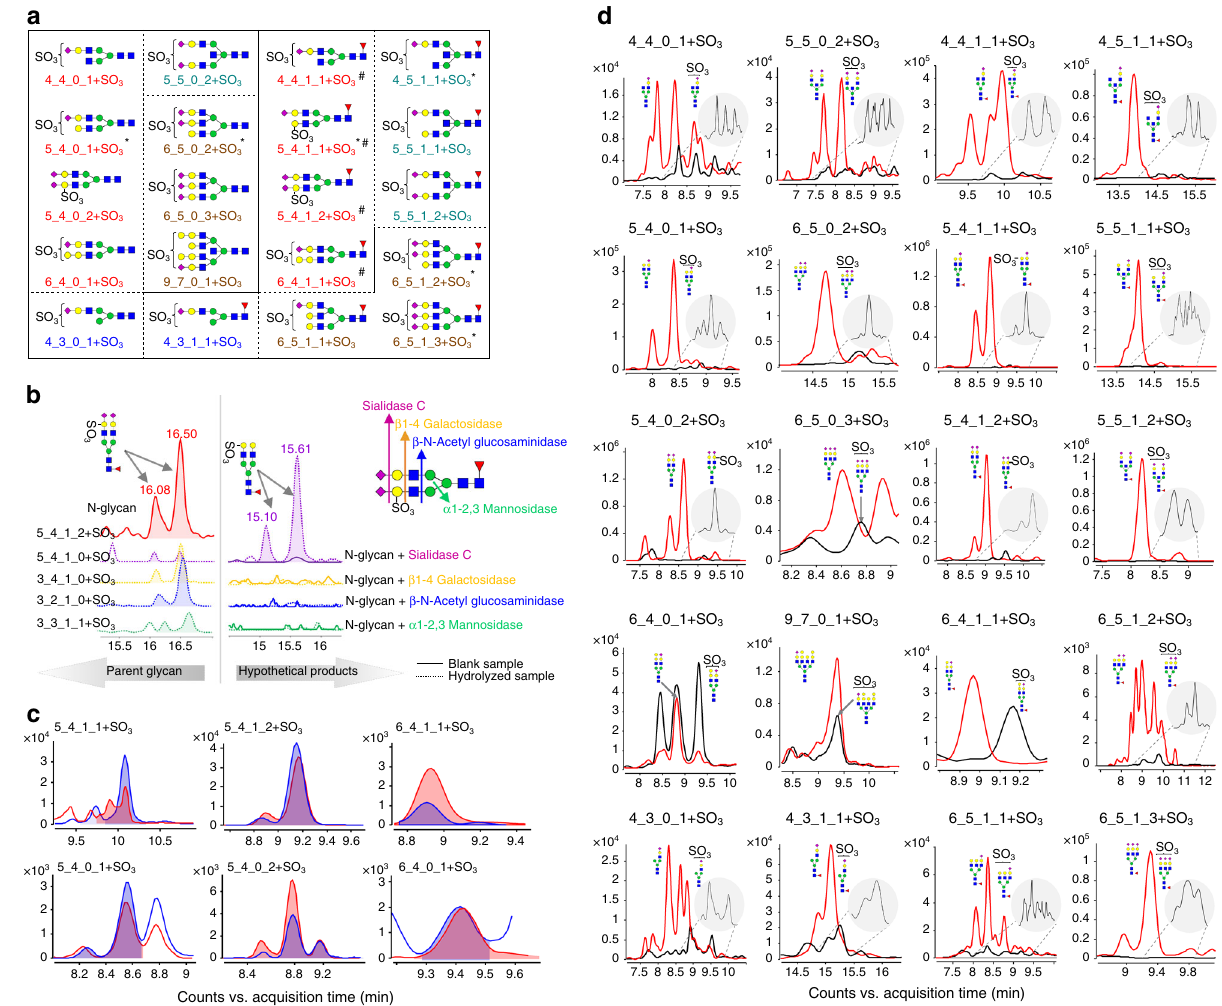
Fig. 4 Structures of sulfated N-glycans identi fi ed on human serum IgGs. a Structures of identi fi ed sulfated N-glycans in human serum IgG. (*represents sulfated N-glycans that have been reported from a human source; # represents sulfated N-glycans that have been reported on porcine thyroglobulin; another 11 sulfated N-glycans have not been previously reported). b Four exoglycosidases, Sialidase C, β 1 – 4 galactosidase, β -N-acetyl glucosaminidase, and α 1 – 2, 3 mannosidase, were employed to hydrolyze the sulfated N-glycans to determine site of the sulfate group. c The retention times and peak patterns of sulfated N-glycans in human IgGs ( red ) were compared with those in porcine thyroglobulin ( blue ), which has been well characterized. d The retention time of each sulfated N-glycan ( black ) is 0.5 min later than its corresponding parent N-glycans ( red ), and the signal intensity is 3-fold to 200-fold lower than that of the non-sulfated